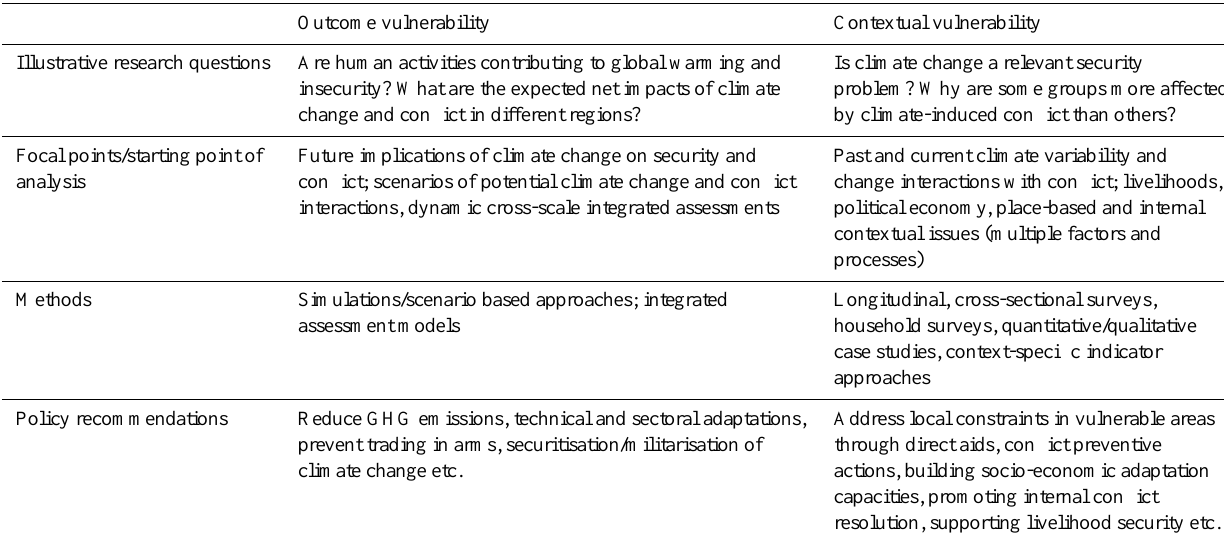
Table 3. Diagnostic tool for identifying different interpretations of vulnerability in climate conflict research (partly based on Füssel, 2007 and O’Brien et al.,